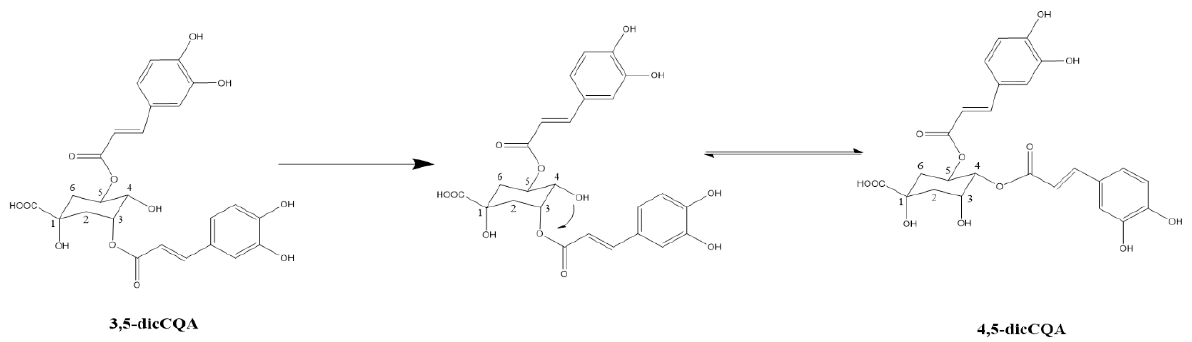
Figure 6. Isomerization reaction of 3,5- O -di-CQA to 4,5- O- di-CQA.